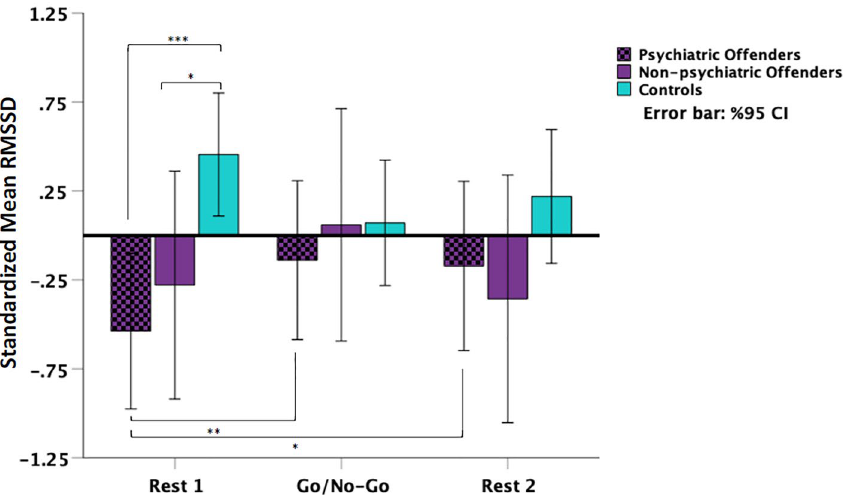
Figure 2. Parasympathetic activity (standardized RMSSD values) broken down by history of psychiatric diagnosis in the offender group compared to controls at baseline (Rest 1), during the emotional Go/No-Go task, and in recovery (Rest 2). Both offender groups, with and without psychiatric diagnoses showed lower RMSSD compared to controls at baseline. In addition, the offenders with psychiatric history showed an increase in their PNS activity during the task compared to baseline, which persisted during recovery. Uncorrected p-values were reported for these exploratory analyses. * p uncorrected < 0.05, ** p uncorrected < 0.01, *** p uncorrected <